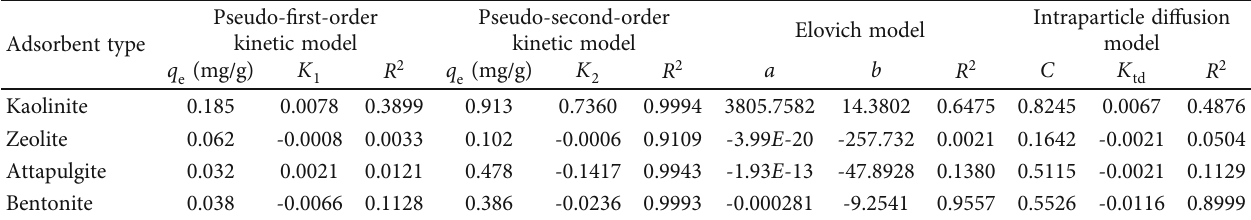
Table 2: Linear form kinetic model parameters of ammonia nitrogen adsorption on NCMs.